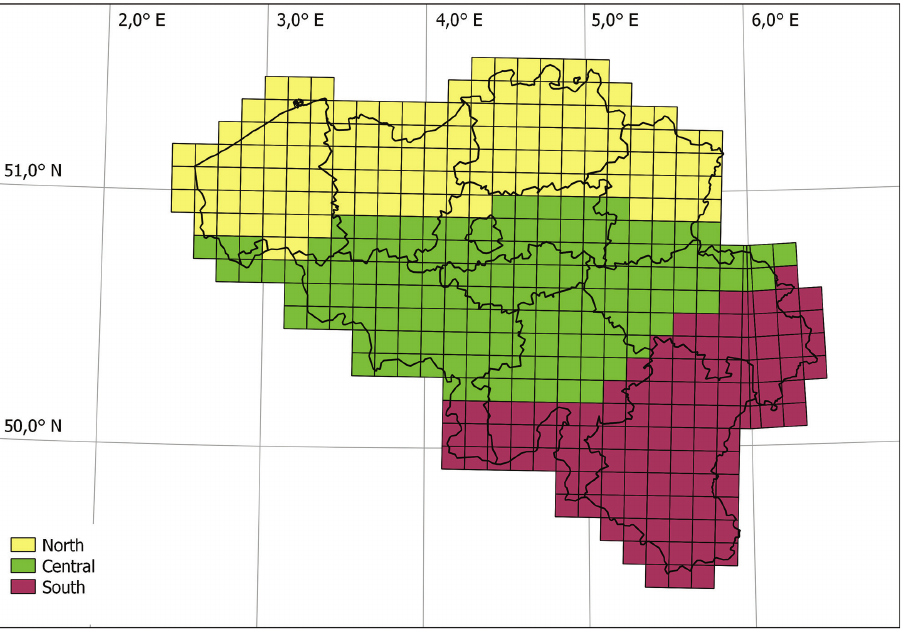
Figure 3. Map of Belgium with the UTM 10×10 km grid. The different colours indicate the different topographical regions used to determine the species